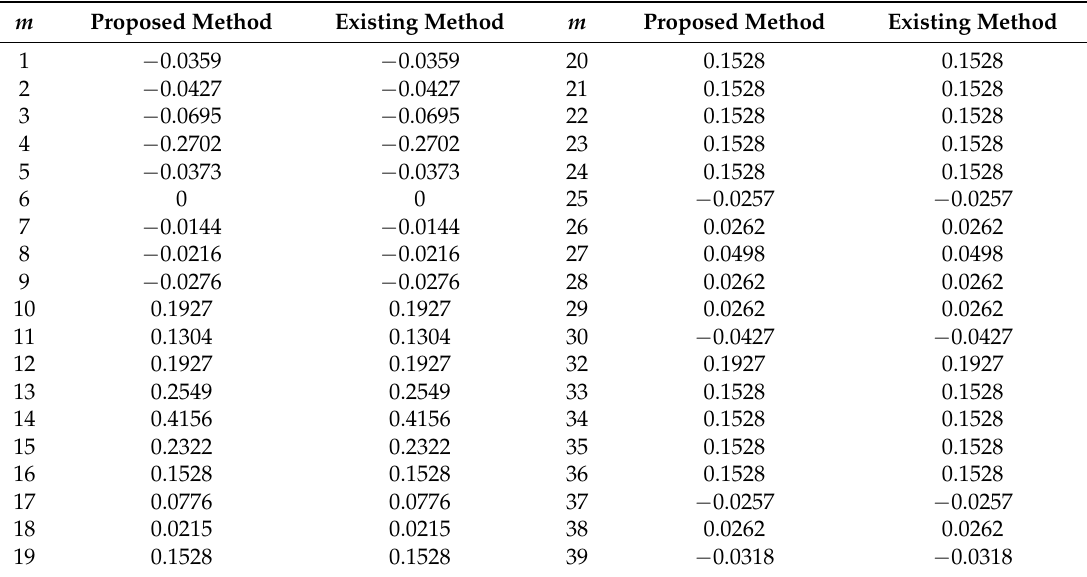
Table 4. HPCs obtained by the proposed method and the existing